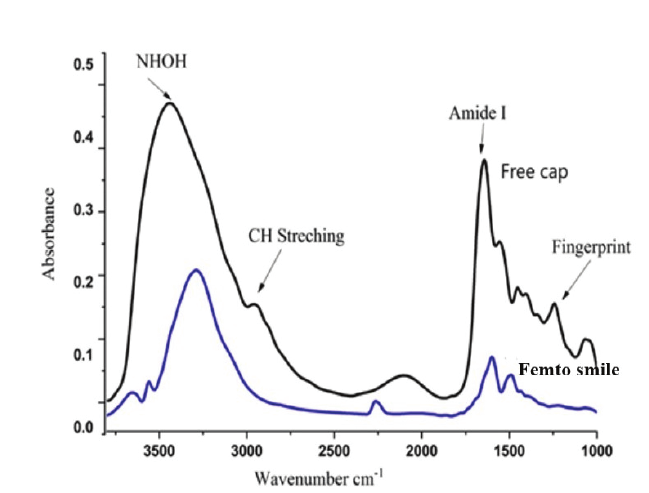
Figure 5. FTIR spectroscopic analysis for the corneal proteins showing the difference between the spectral profile for the free cap group and Femto SMILE groups in the NH-OH (3000–3700 cm −1 ), CH stretching (2800–3000 cm −1 ), Amide I (1700–1800 cm −1 ), and fingerprint regions (1000–1800 cm −1